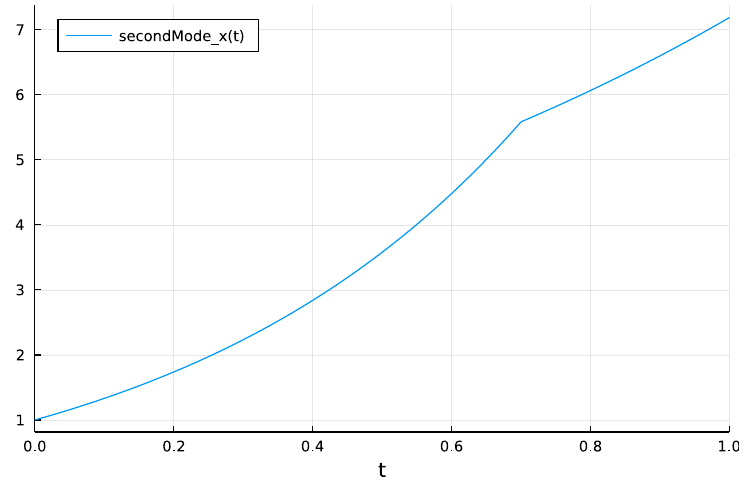
Figure 6. The result of simulating Listing